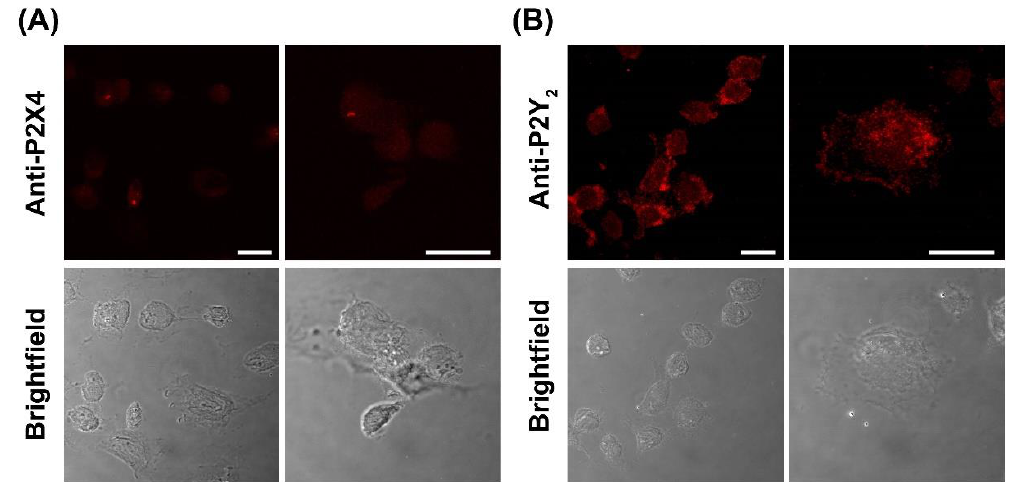
Figure 9. Expression of P2X4 and P2Y 2 receptors in DH82 cells. DH82 cells were fixed, permeabilized and labelled with ( A ) anti-P2X4 or ( B ) anti-P2Y 2 receptor primary antibodies, then with anti-goat 594 or anti-rabbit 594 secondary antibodies, respectively. Cells were imaged by confocal microscopy. Scale bar = 20 µm. Results are representative of three independent experiments.